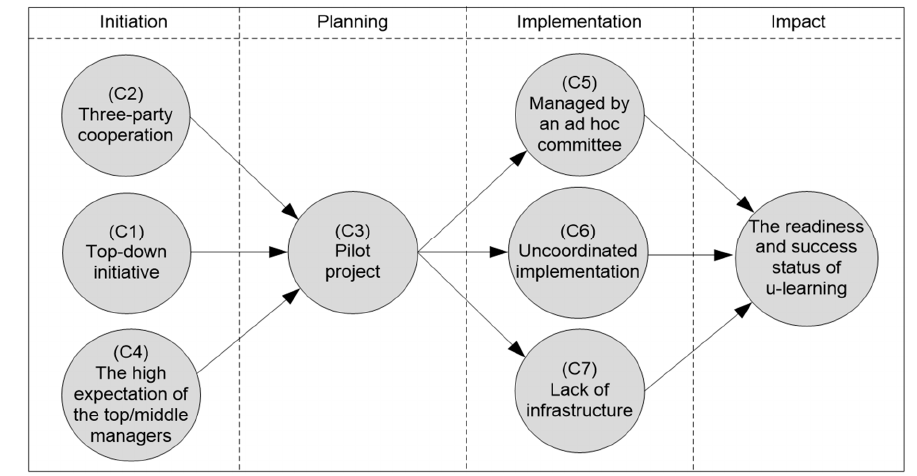
Figure 6. Readiness and success status of u-learning based on its implementation